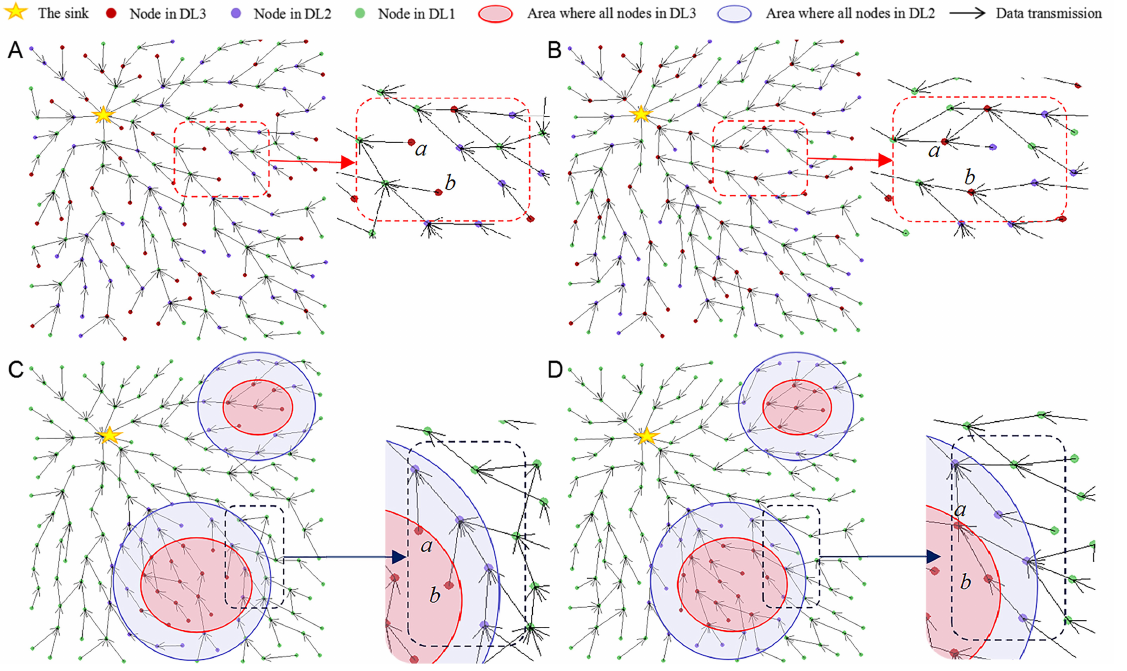
Figure 18. Compared to nodes of TPGFPlus-IND, those of THECB prefer to select the nodes in DL 2 and DL 1 to relay data, that is, nodes in DL 3 have less data forwarding traffic, e.g., node a and b . ( A ) Node a and b of THECB are not selected as next hop nodes. ( B ) Node a and b of TPGFPlus-IND are selected as next hop nodes. ( C ) Node a and b of THECB are not selected as next hop nodes. ( D ) Node a and b of TPGFPlus-IND are selected as next hop